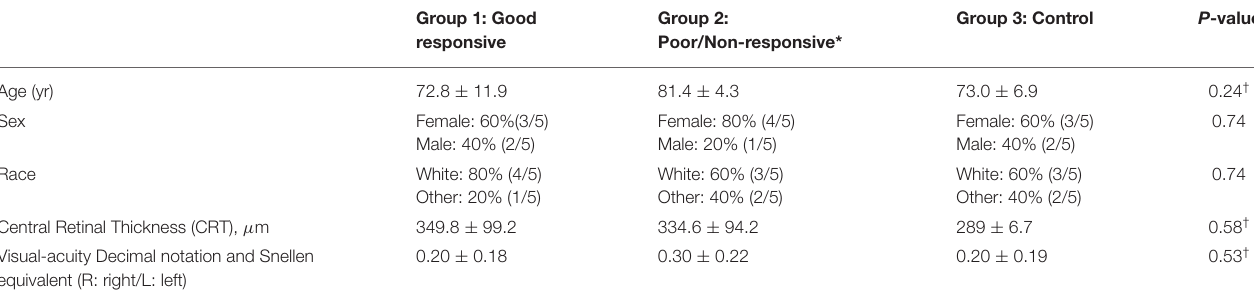
Group 1: Good Group 2: Group 3: Control P -value responsive Poor/Non-responsive* Female: 80% (4/5) Female: 60% (3/5) 0.74 Male: 40% (2/5) Male: 20% (1/5) Male: 40% (2/5) White: 60% (3/5) White: 60% (3/5) 0.74 Other: 20% (1/5) Other: 40% (2/5) Other: 40% (2/5) 0.20 ± 0.18 0.30 ± 0.22 0.53